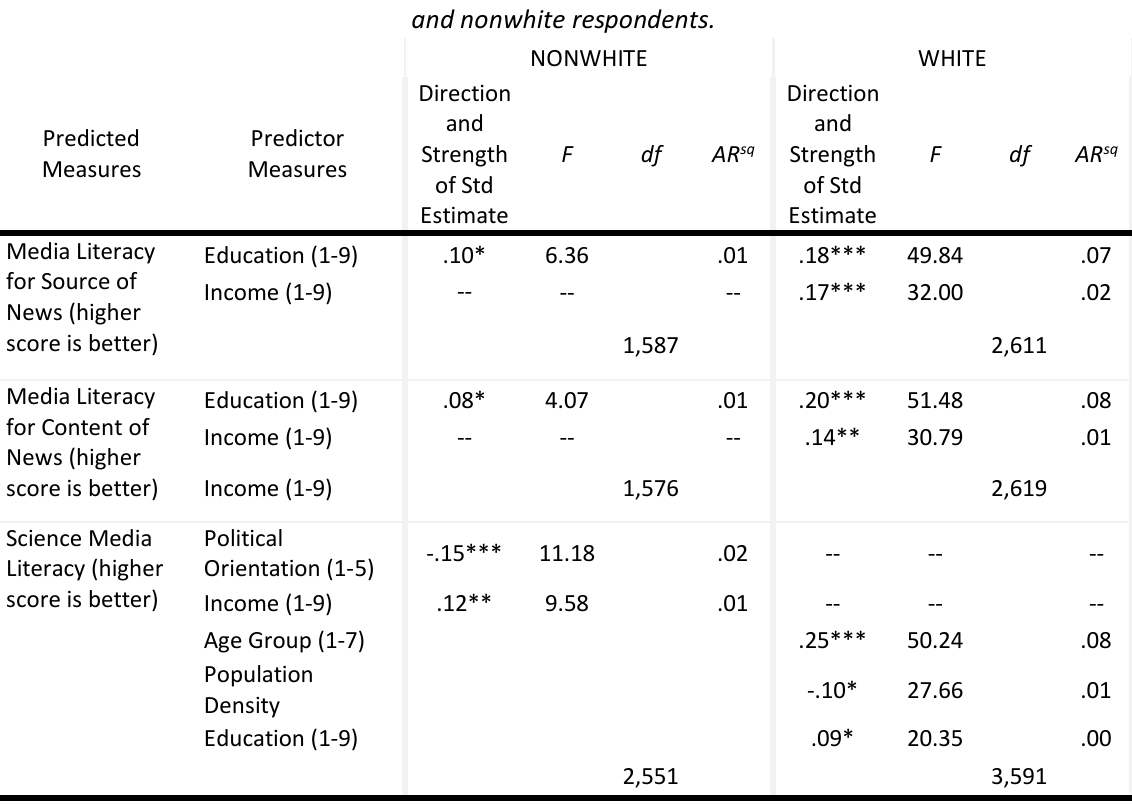
Finding 4: As shown in Table 3, nonwhite participants higher on COVID-19 disinformation beliefs tended to be male, lower in science media literacy, and lower on media literacy for source after science